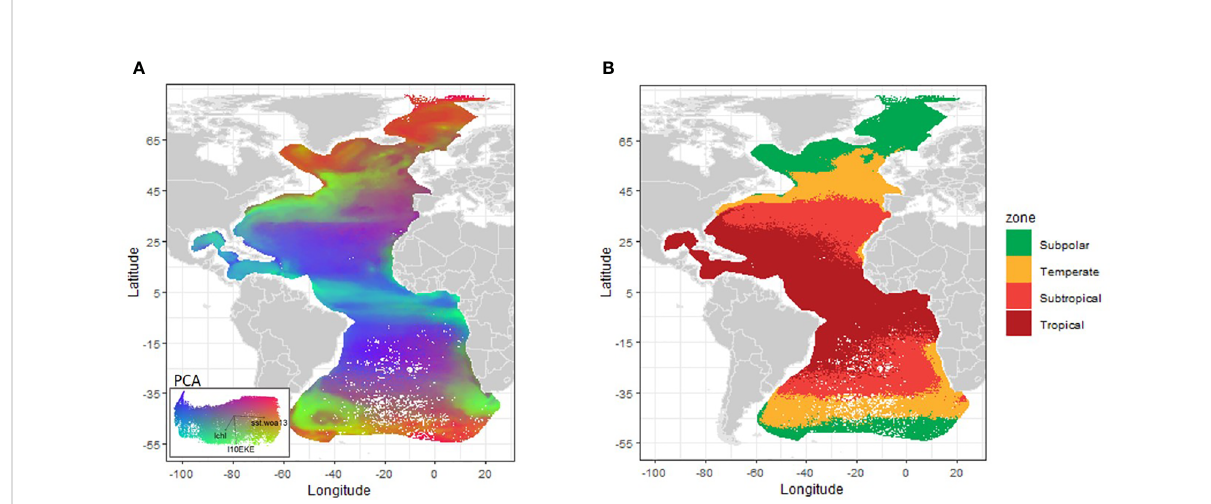
FIGURE 6 Changes of foraminifera community composition (species turnover) predicted by the Gradient Forest Analysis. These changes have been mapped over the fi rst dimensions of a biologically transformed environmental space that accounts for their respective in fl uence in dictating compositional patterns. (A) - map of species turnover and respective PCA; right panel: (B) - Map showing the spatial groups resulting of the k- means cluster analysis and corresponding zones (note the colors and names used are the same as in Kuc ̌ era, 2007 to facilitate the comparison).(the geographic fi les of the zones are available upon request by email to the fi rst